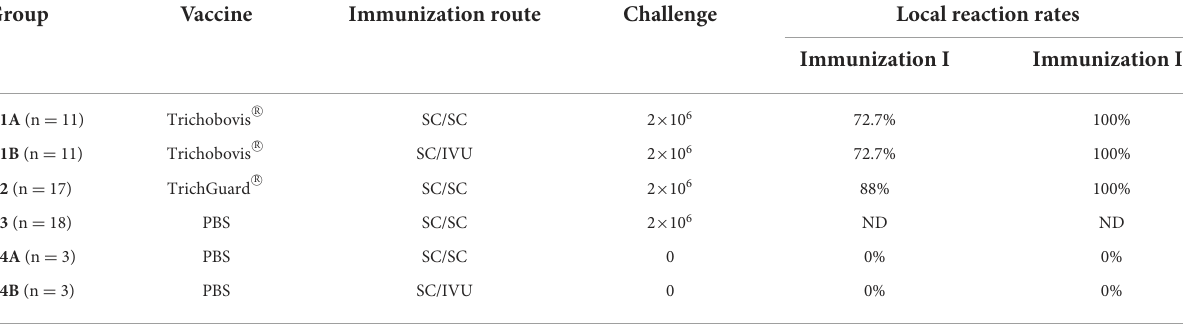
TABLE 1 Experimental design and local reaction rates of the study no. 1 after the first and second immunisations. Group Vaccine Immunization route Challenge Local reaction rates